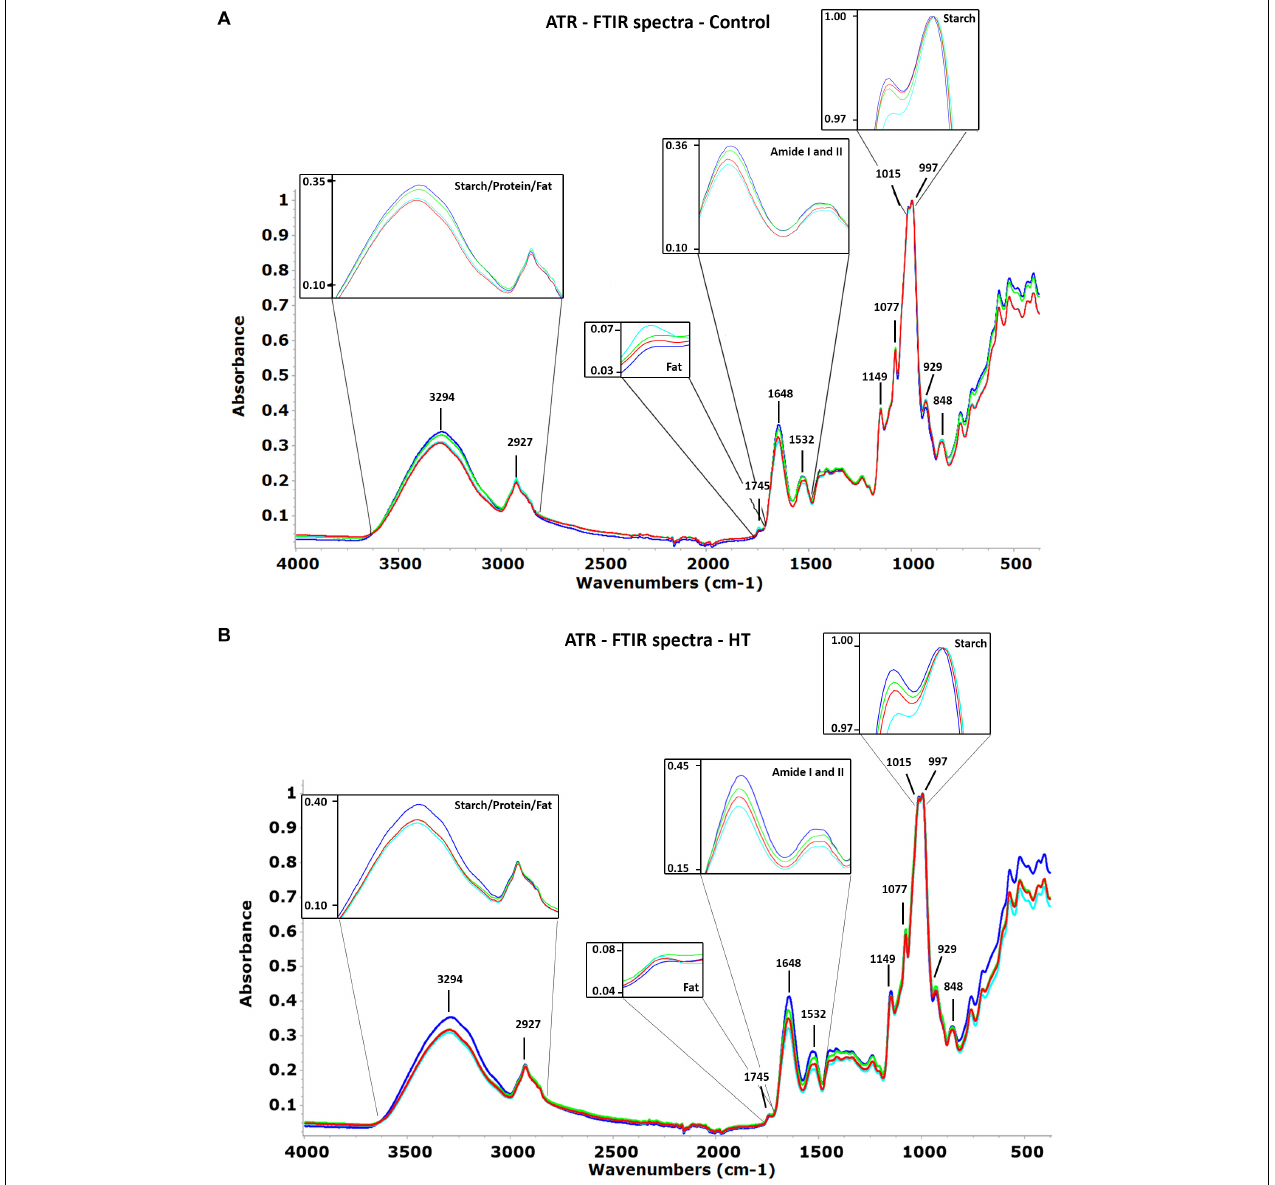
FIGURE 3 | Attenuated total reflection Fourier transform infrared (ATR-FTIR) average spectra of Ardito (dark blue), Grécia (green), Magueija (light blue), and Ruivo (red) (A) control and (B) HT samples with the assignment of relevant bands. Insets magnify peaks related with starch, protein, and fat showing differences between landraces in each